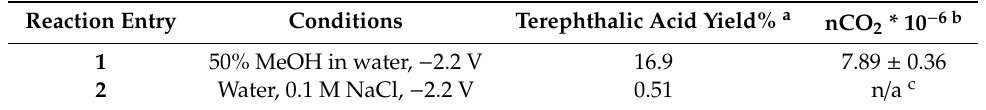
Table 3. Reactions at room temperature (21 ◦ C), for 1h in a batch electrolysis H-Cell divided by a coarse ceramic frit at controlled potential against a single-junction Ag / AgCl reference electrode with 20 mg PET